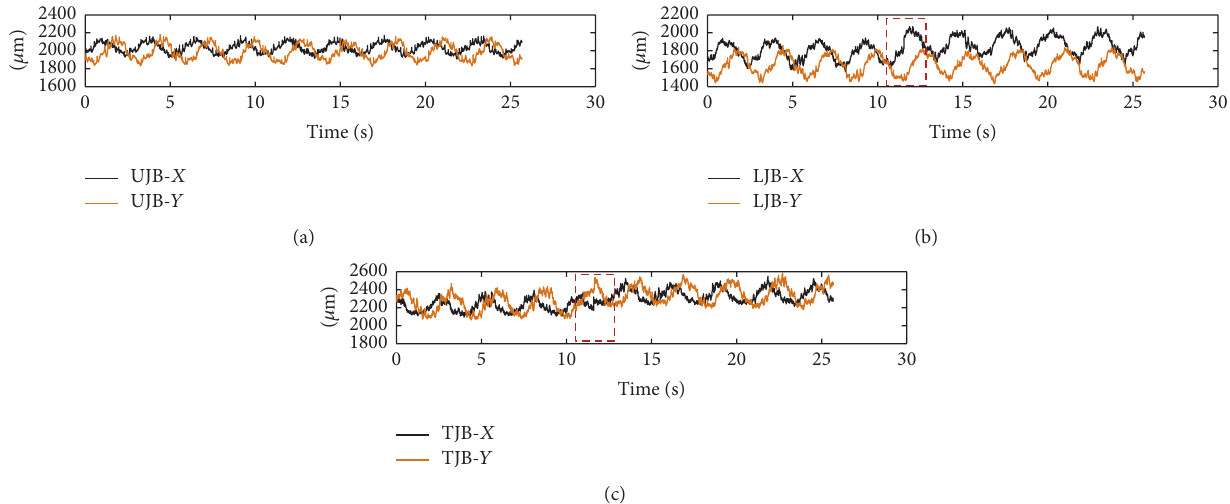
Figure 7: Shaft relative vibrations at the upper (UJB- 𝑋/𝑌 ), lower (LJB- 𝑋/𝑌 ), and turbine (TJB- 𝑋/𝑌 ) journal bearings of a LHG operating with 247